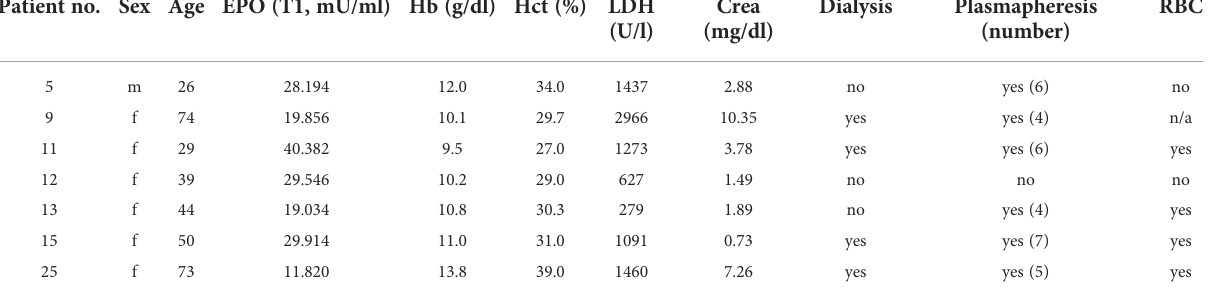
TABLE 1 Hematological, laboratory and renal function parameters in the subgroup of patients with STEC-HUS assessed at hospital